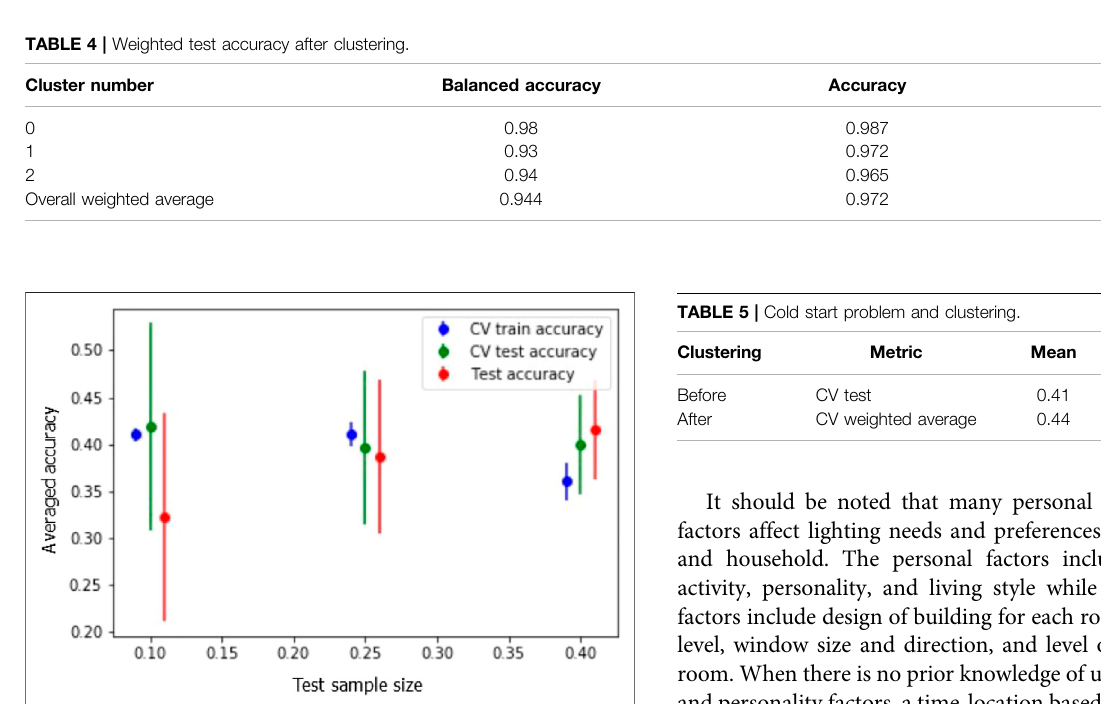
FIGURE 6 | Random sampling on household separation result.